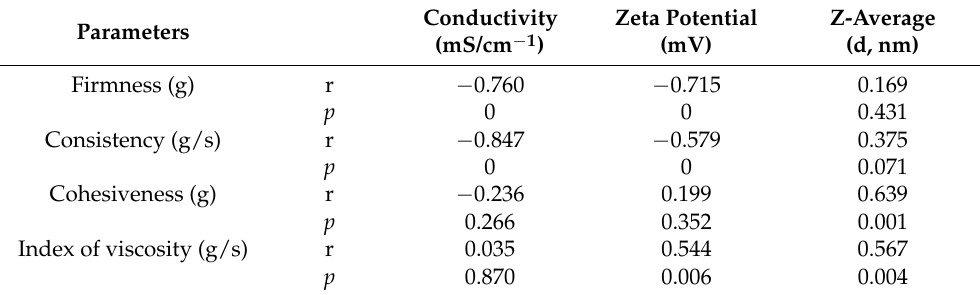
Table 4. Correlation analysis of electrical properties and particle size of polymerized whey protein depending on the heating time on its texture and